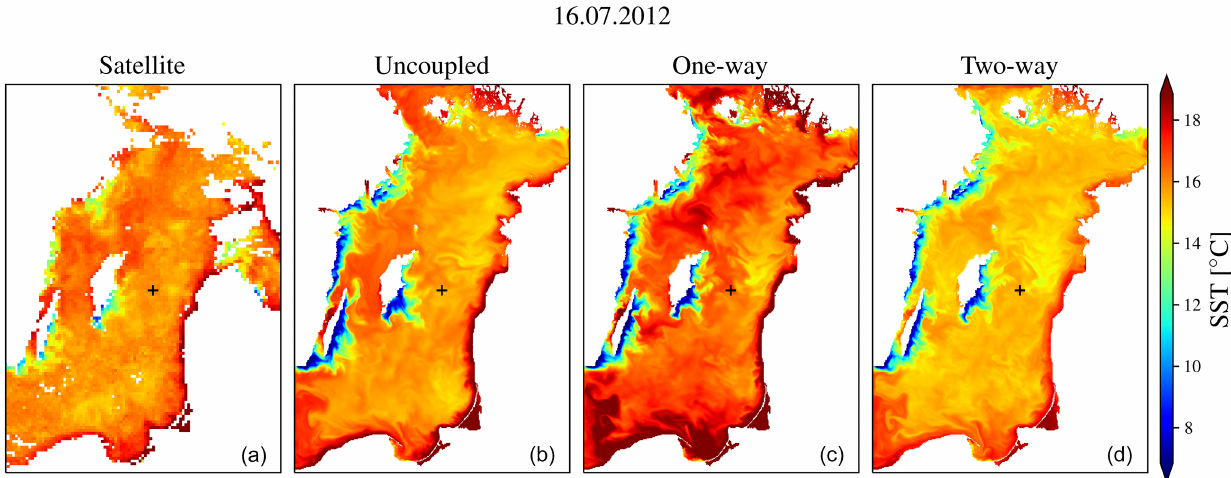
Figure 13. Daily mean sea surface temperature from satellites (a) and simulated by GETM in the uncoupled (b) , one-way (c) and two-way (d) coupled simulation for 16 July 2012. The colour bar is identical to Fig. 7. The SST derived from satellite data was provided by the Federal Maritime and Hydrographic Agency of Germany (BSH). The black cross marks the position of station TF271 in the Eastern Gotland